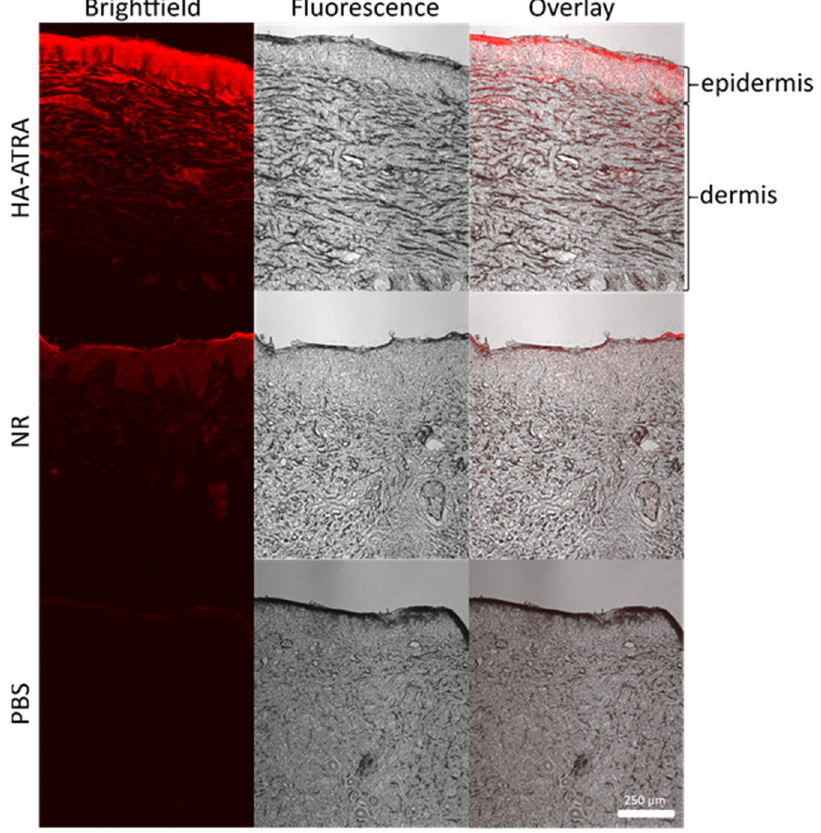
Figure 4. Skin penetration was followed for 24 h in Franz diffusion cells. The amphiphilic derivative made of trans-retinoic acid grafted to hyaluronan was loaded with Nile Red (NR), NR dispersed in PBS and PBS were used as control [6]. Copyright 2020, with permission from Elsevier.